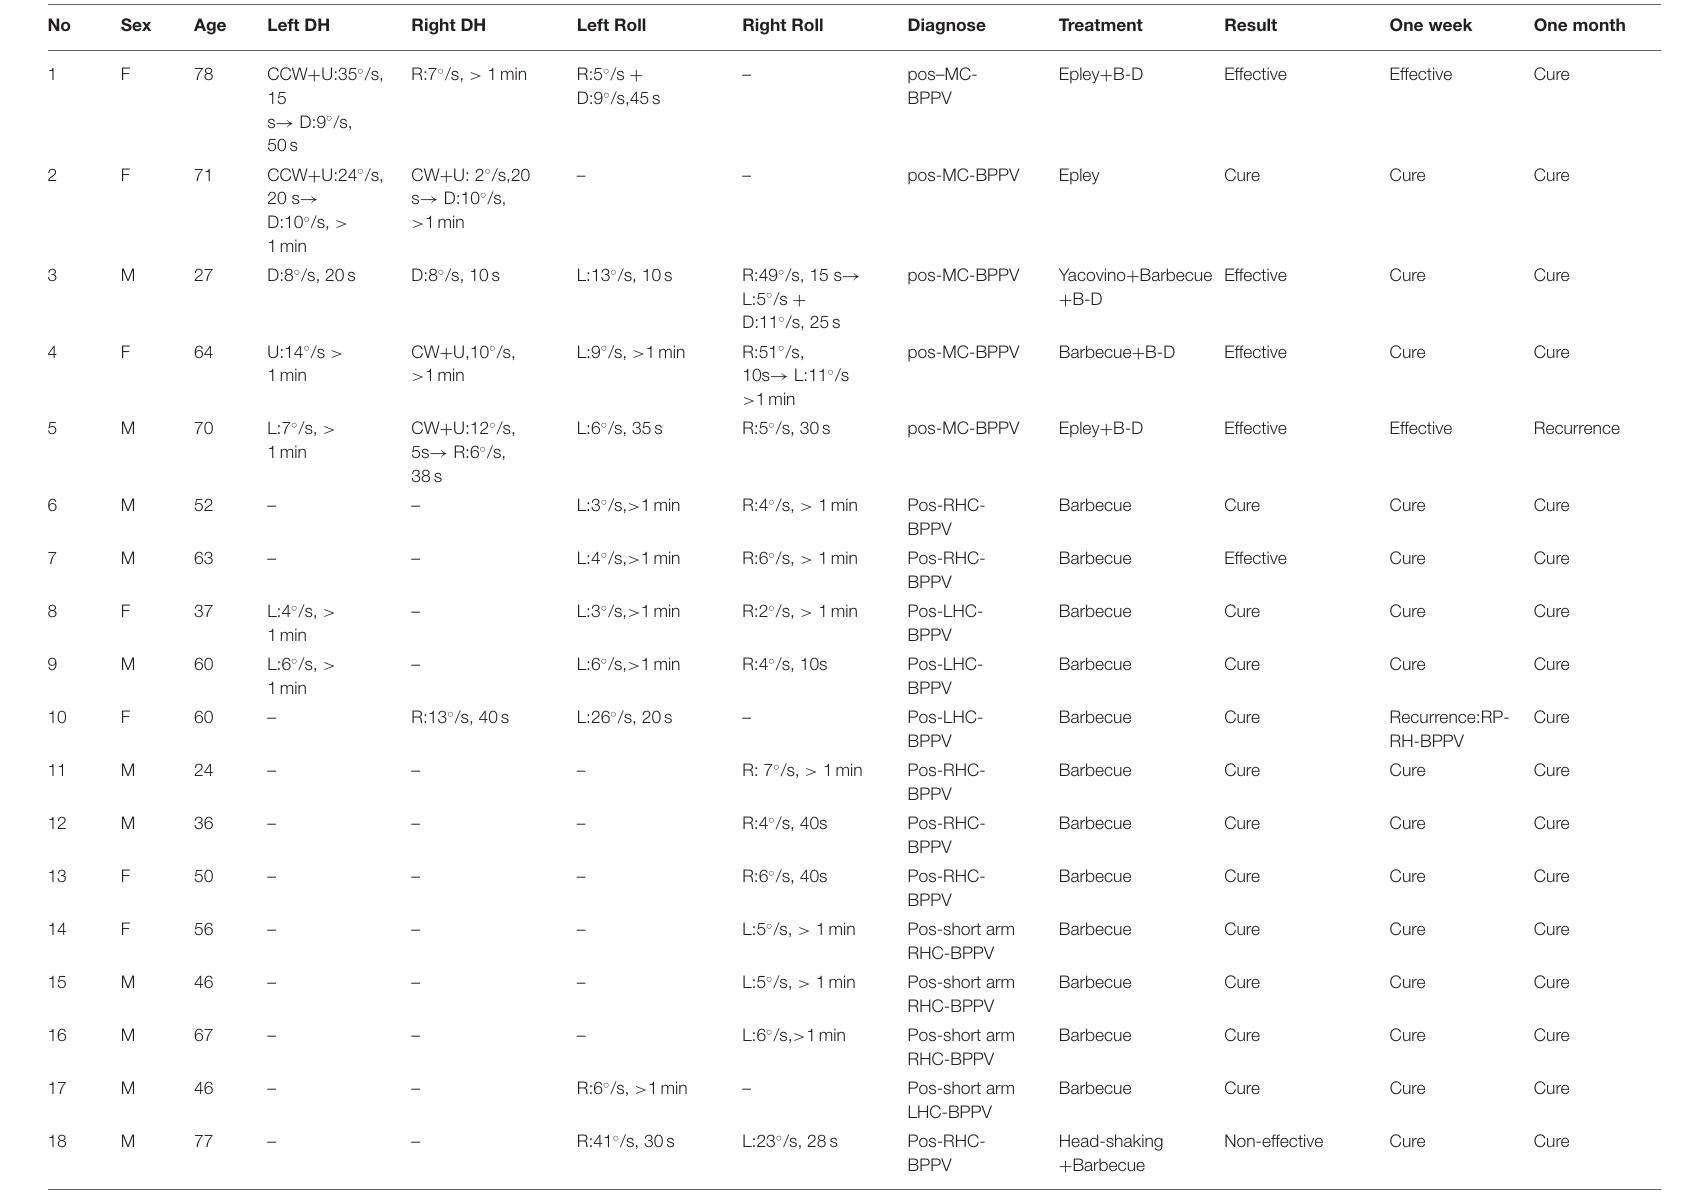
TABLE 1 | Clinical features of the Possible